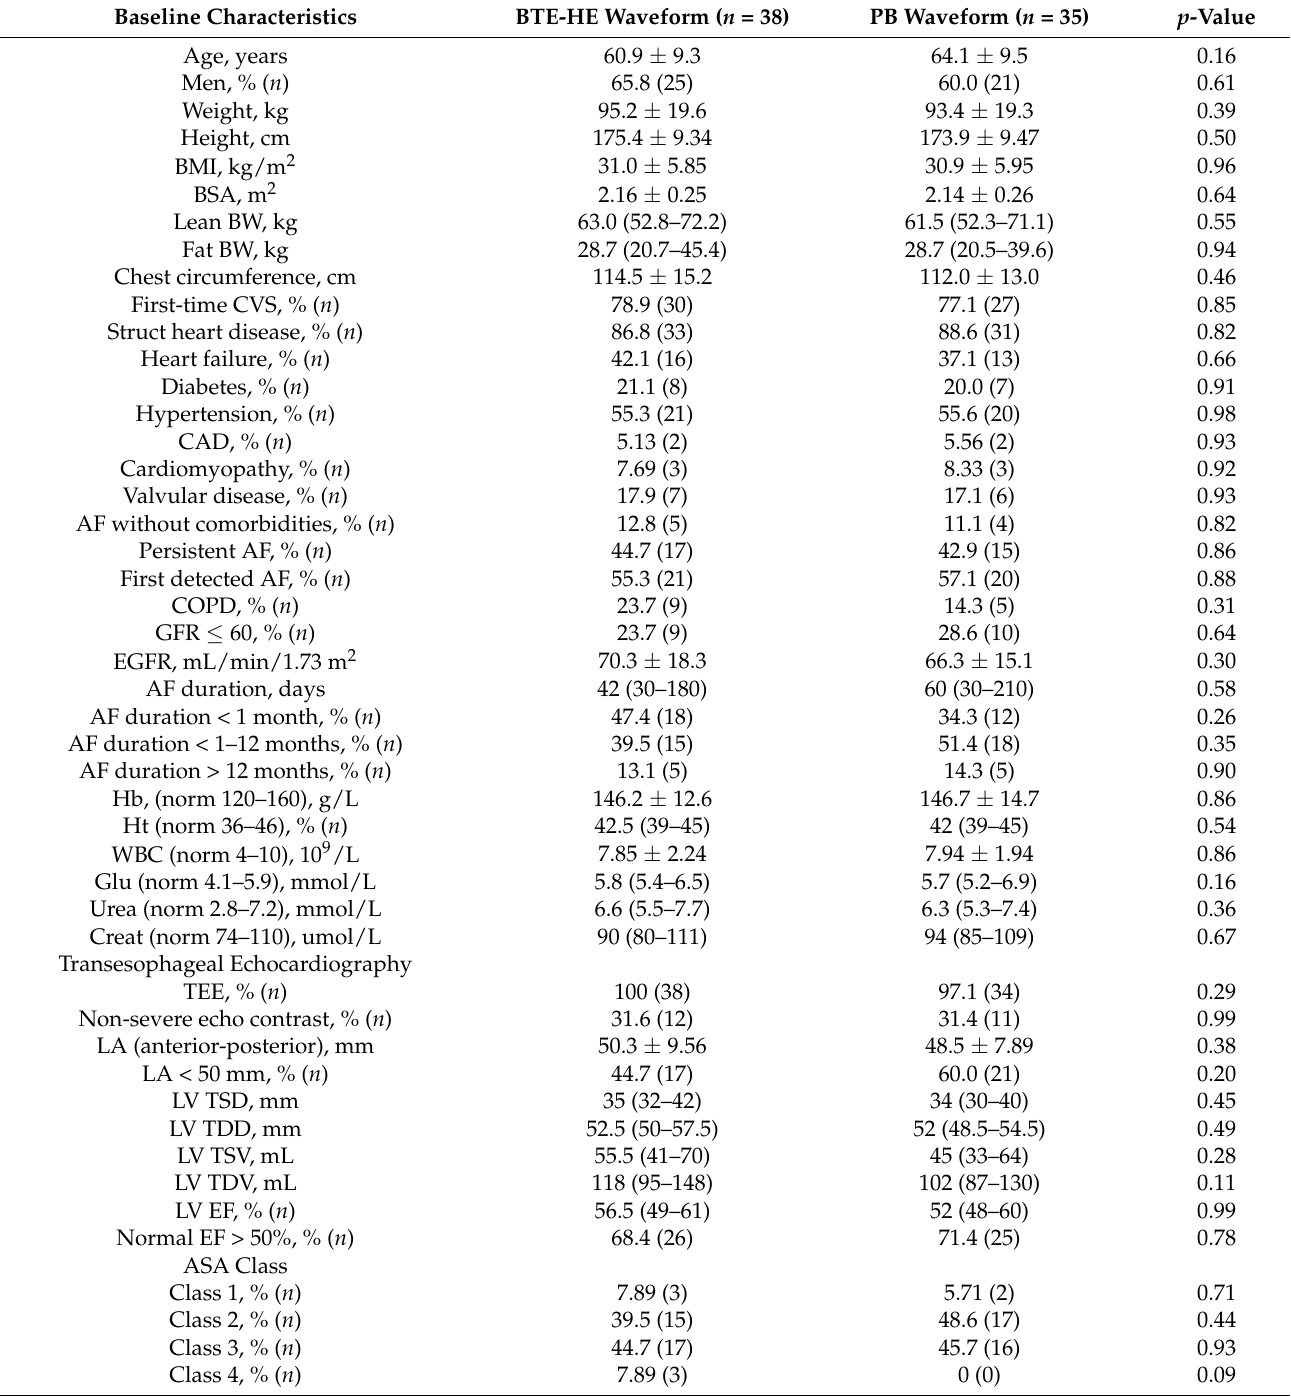
Table 1. Baseline characteristics of patients in the two study arms. Data were reported as mean ± standard deviation or median (inter-quartile range) for continuous variables and percentages (counts) for categorical variables. All baseline data were not significantly different in both groups ( p >